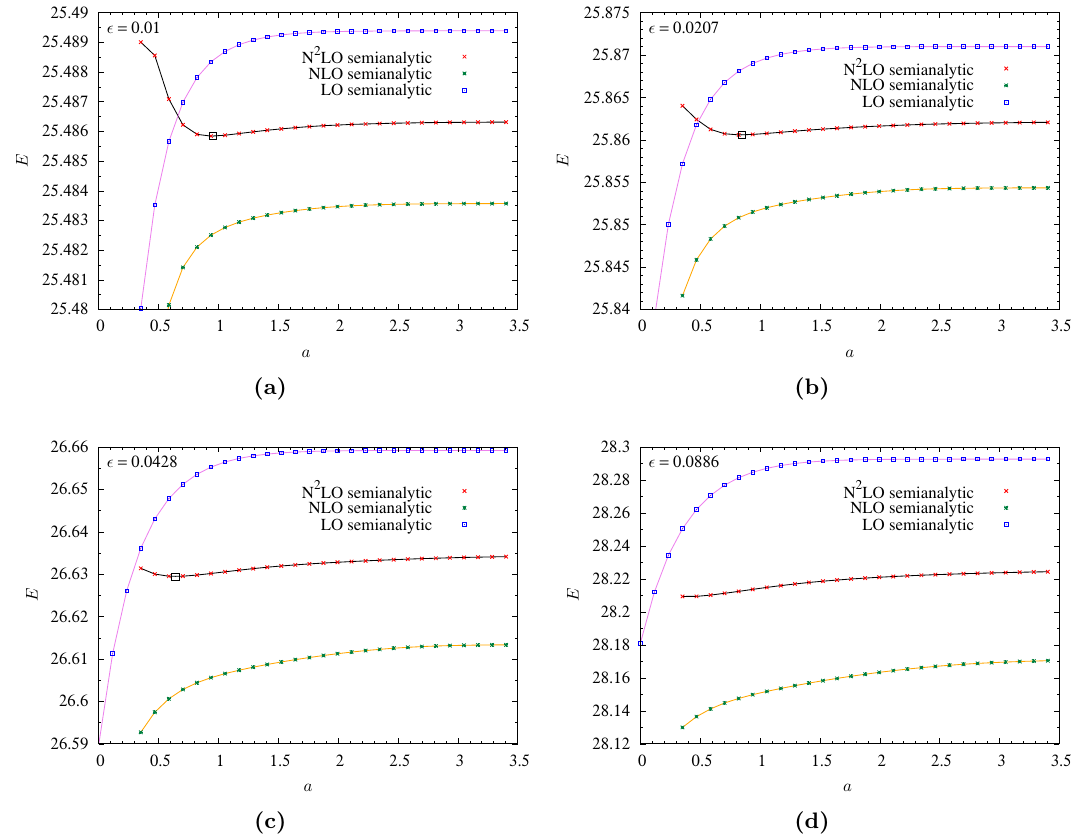
Figure 15. The LO (blue squares), NLO (green crosses) and N 2 LO corrections (red crosses) to the energy of two N = 1 baby Skyrmions as functions of the separation distance 2 a , see figure 13. The panels show different values of (cid:15) : (a) (cid:15) = 0 . 01 , (b) (cid:15) = 0 . 0207 , (c) (cid:15) = 0 . 0428 and (d) (cid:15) = 0 . 0886 . The LO energy is calculated by geometrically cutting off the BPS energy plus the LO correction at the gluing line ( x 1 = 0 ) (and multiplying by 2). A large black square shows the minimum of the N 2 LO